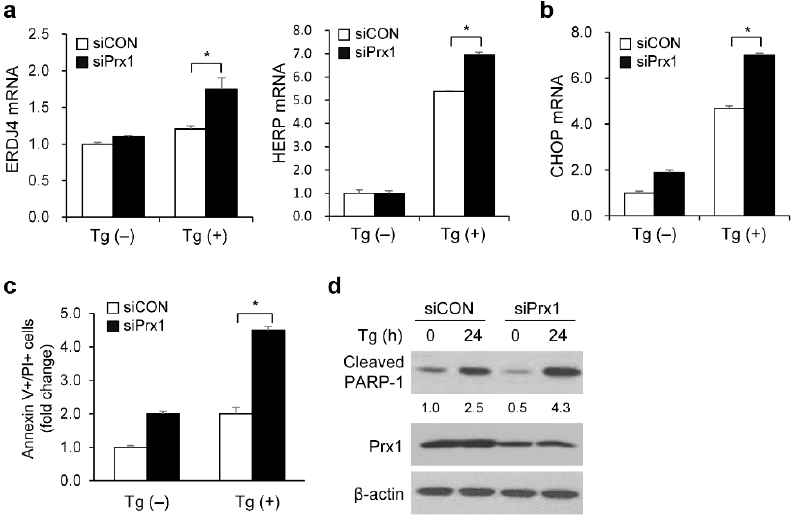
Figure 3. Prx1 knockdown accelerates ER stress-induced UPR activation, CHOP pathway, and apoptosis. ( a ) Prx1 knockdown accelerates the expression of ERDJ4 and HERP mRNA with Tg treatment. HEK293 cells transfected with siRNA against a siCON or siPrx1 were incubated with or with ‐